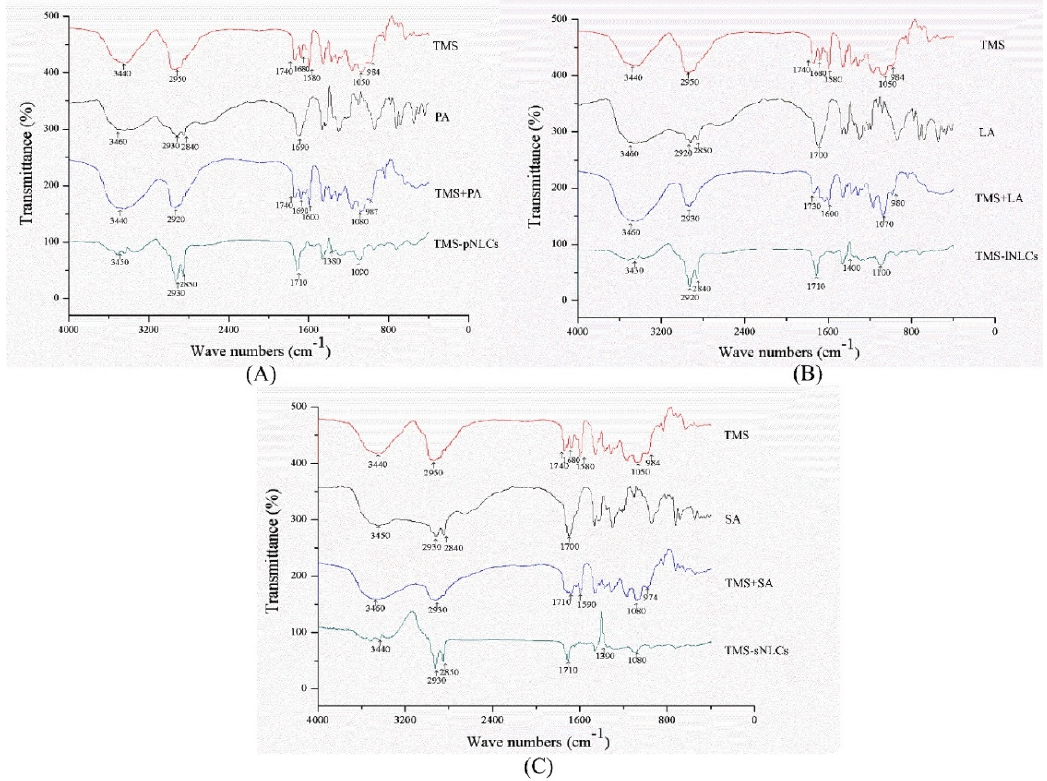
Figure 4. Fourier transformed infrared spectroscopy (FT-IR) of TMS-pNLCs ( A ), TMS-lNLCs ( B ), and TMS-sNLCs ( C ).